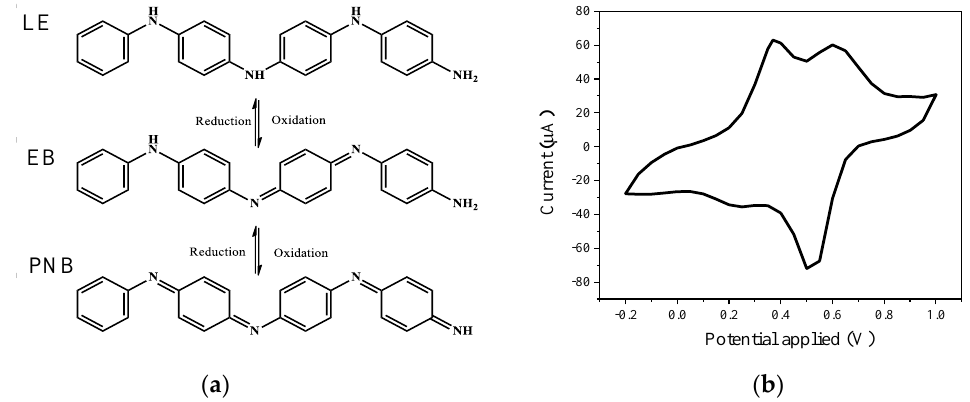
Figure 4. ( a ) Molecular structures of tetraaniline (TA) with different redox states, ( b ) cyclic voltammetry measurement for synthesized TA. LE—leucoemeraldine base; EB—emeraldine base; PNB— pernigraniline base.